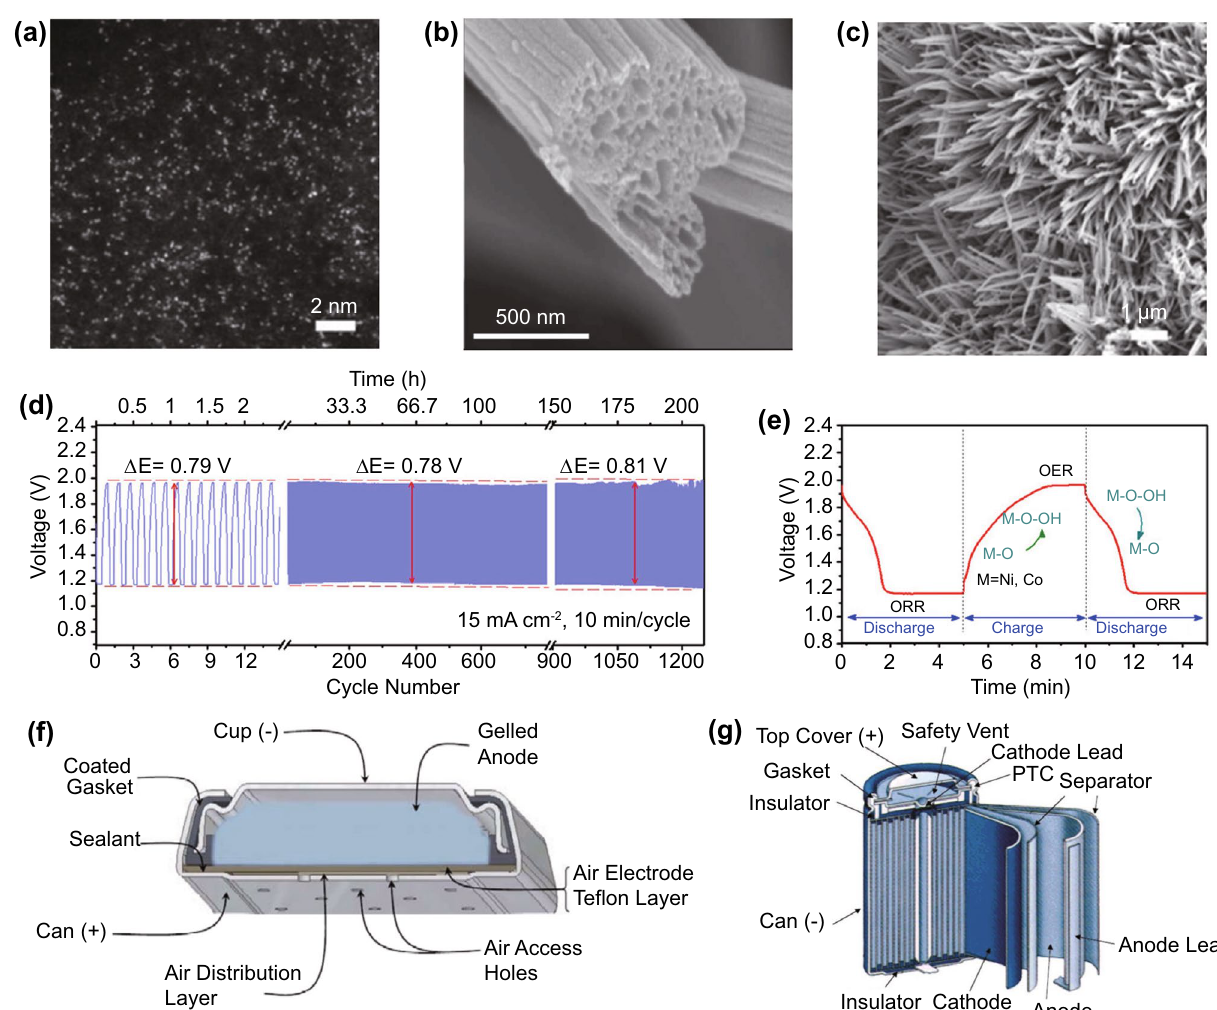
Fig. 14 a Transmission and b , c scanning electron micrographs of various air cathode catalyst structures. a Pt single atoms on a graphdiyne substrate [208] . Copyright 2018, John Wiley and Sons. b porous nitrogen-doped carbon fibre [204] . Copyright 2013, Elsevier. c Co 3 O 4 nanow- ire core and NiFe-layered double hydroxide shell (LDH) structures. Electrochemical performance of the Co3O4@NiFe LDH catalyst, showing d high cycle stability but e the characteristically low round trip efficiency caused by the large potential gap between the ORR and OER [209]